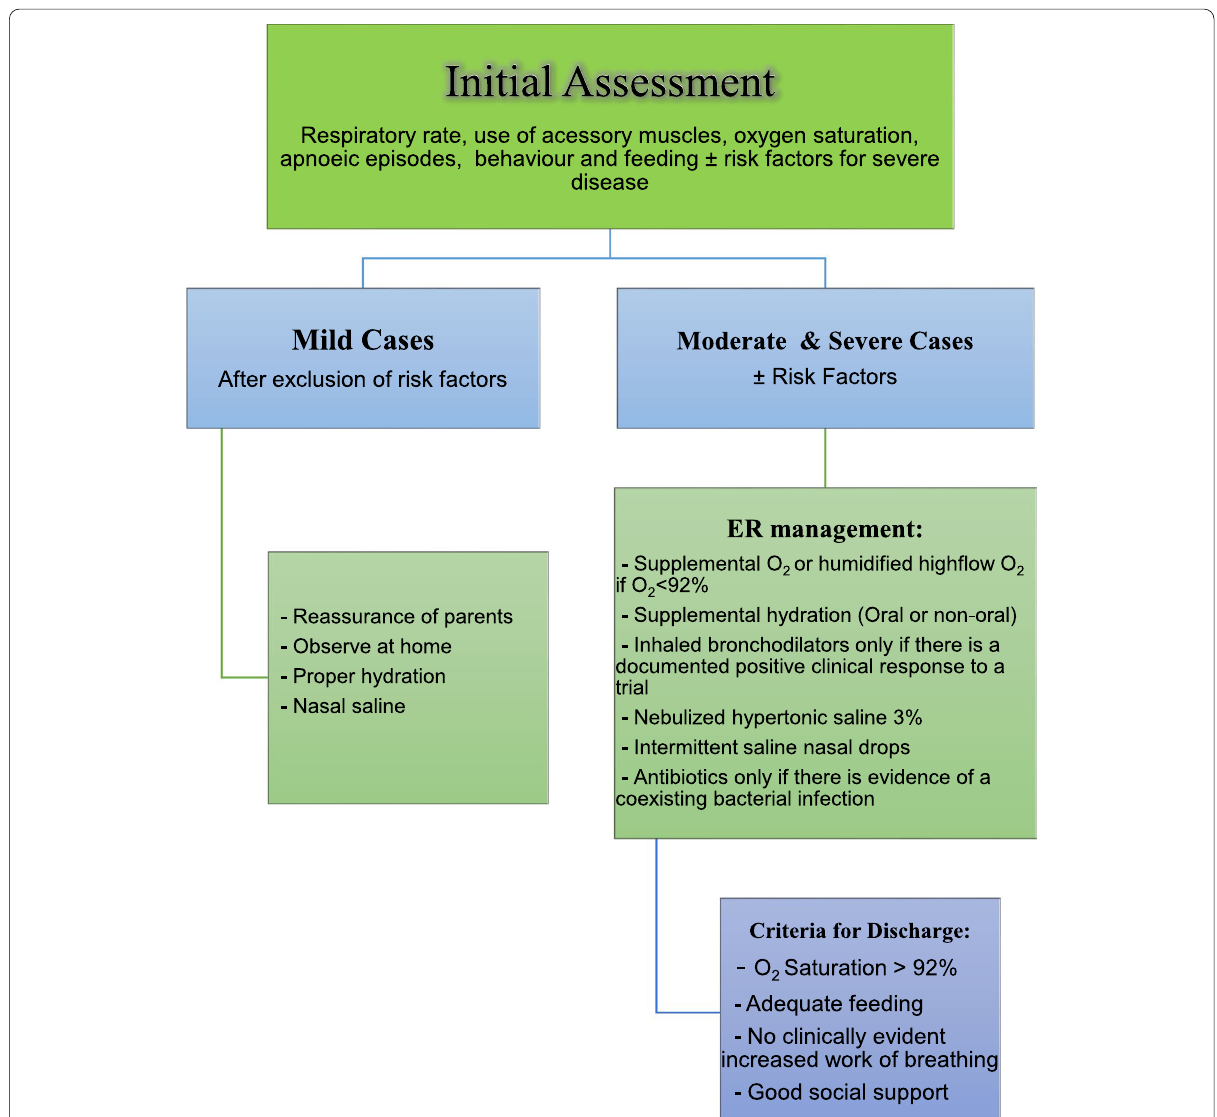
Fig. 1 Algorithm for treatment of acute bronchiolitis in the emergency room (designed by the BGAG according to the key